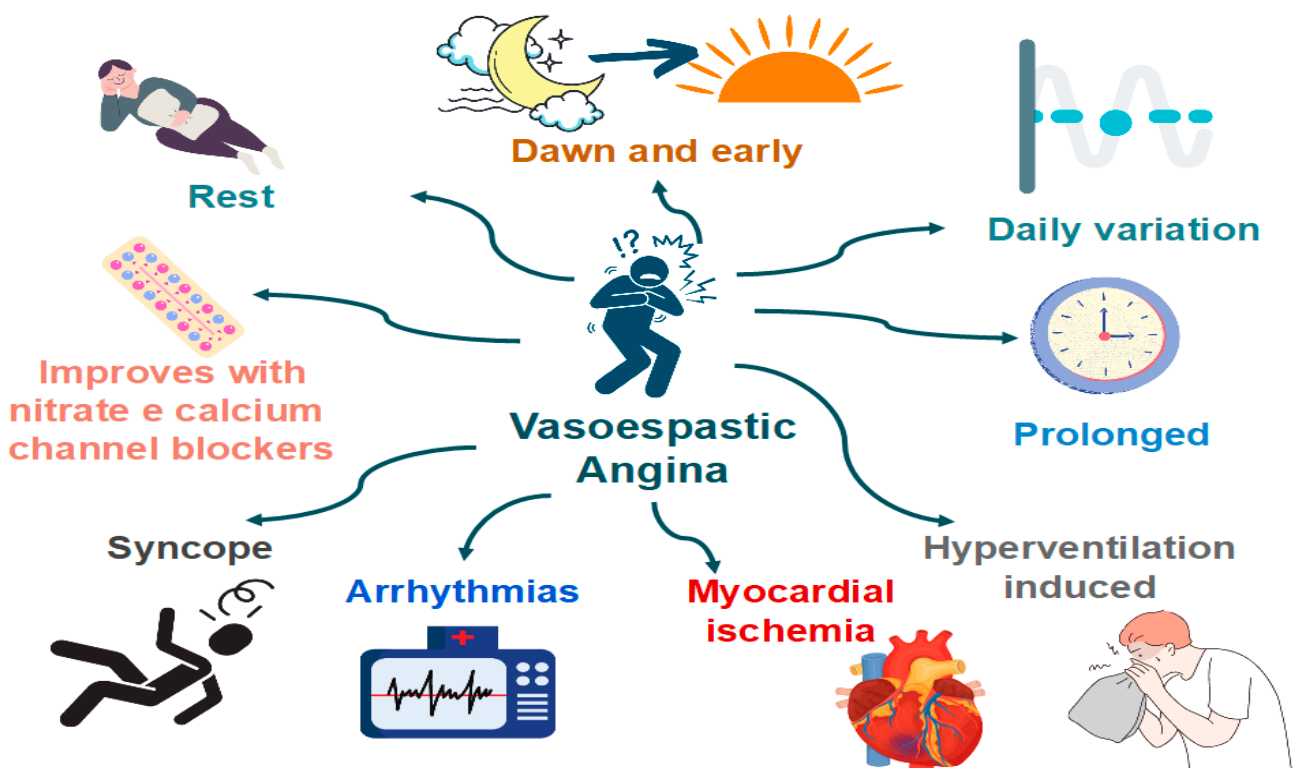
Figure 5. Clinical manifestations of coronary artery spasm (CAS).